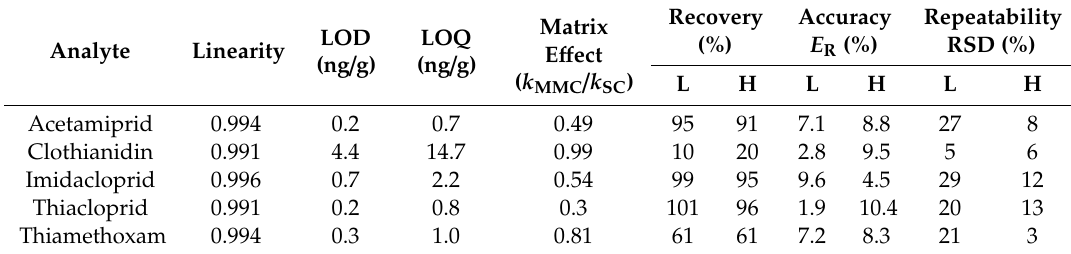
Table 1. Validation results of the SPE-LC-MS / MS method.